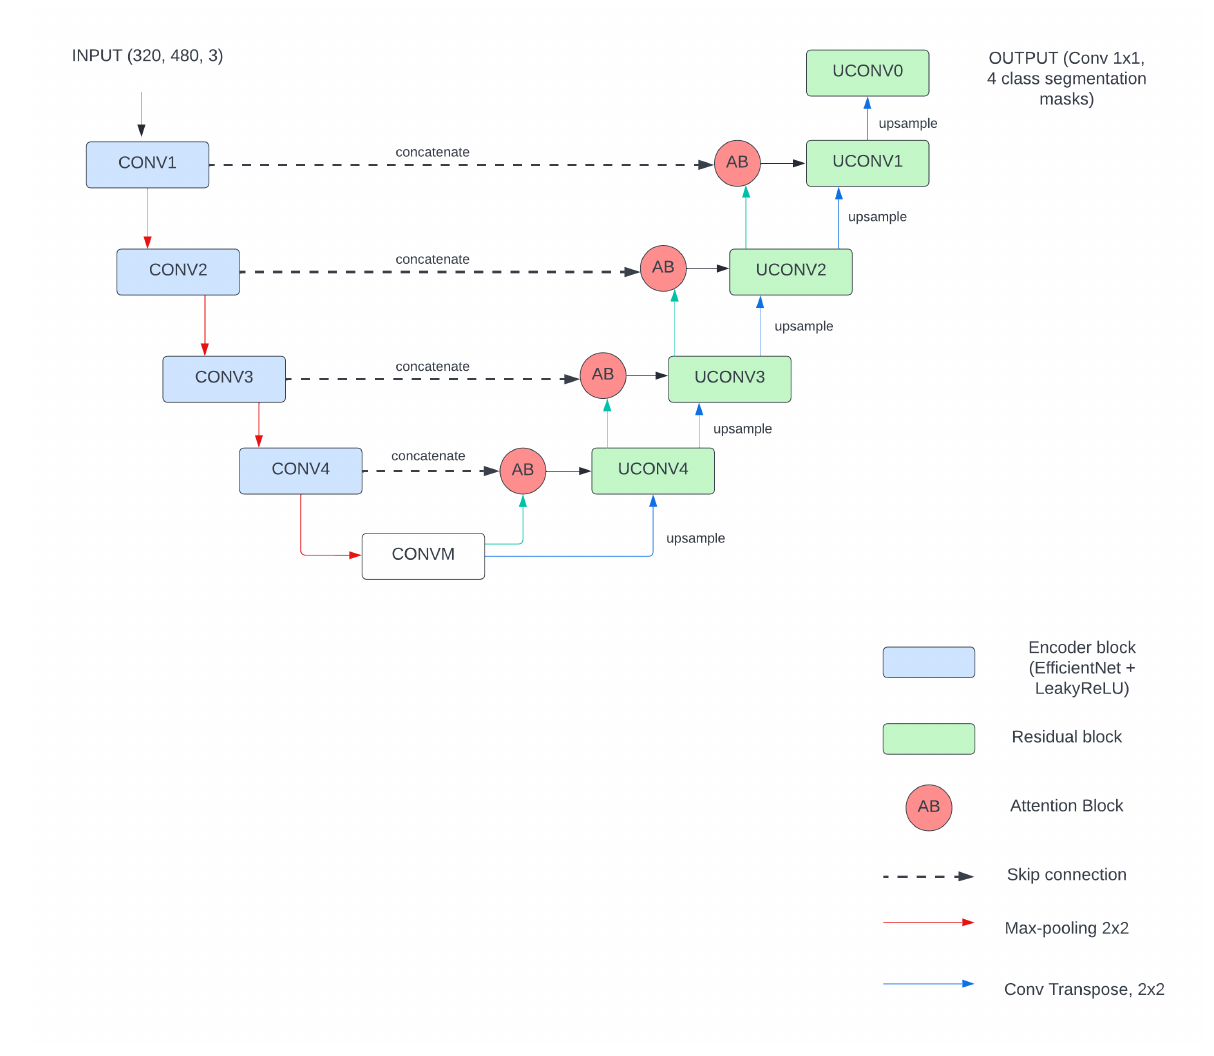
Figure 5. Proposed model